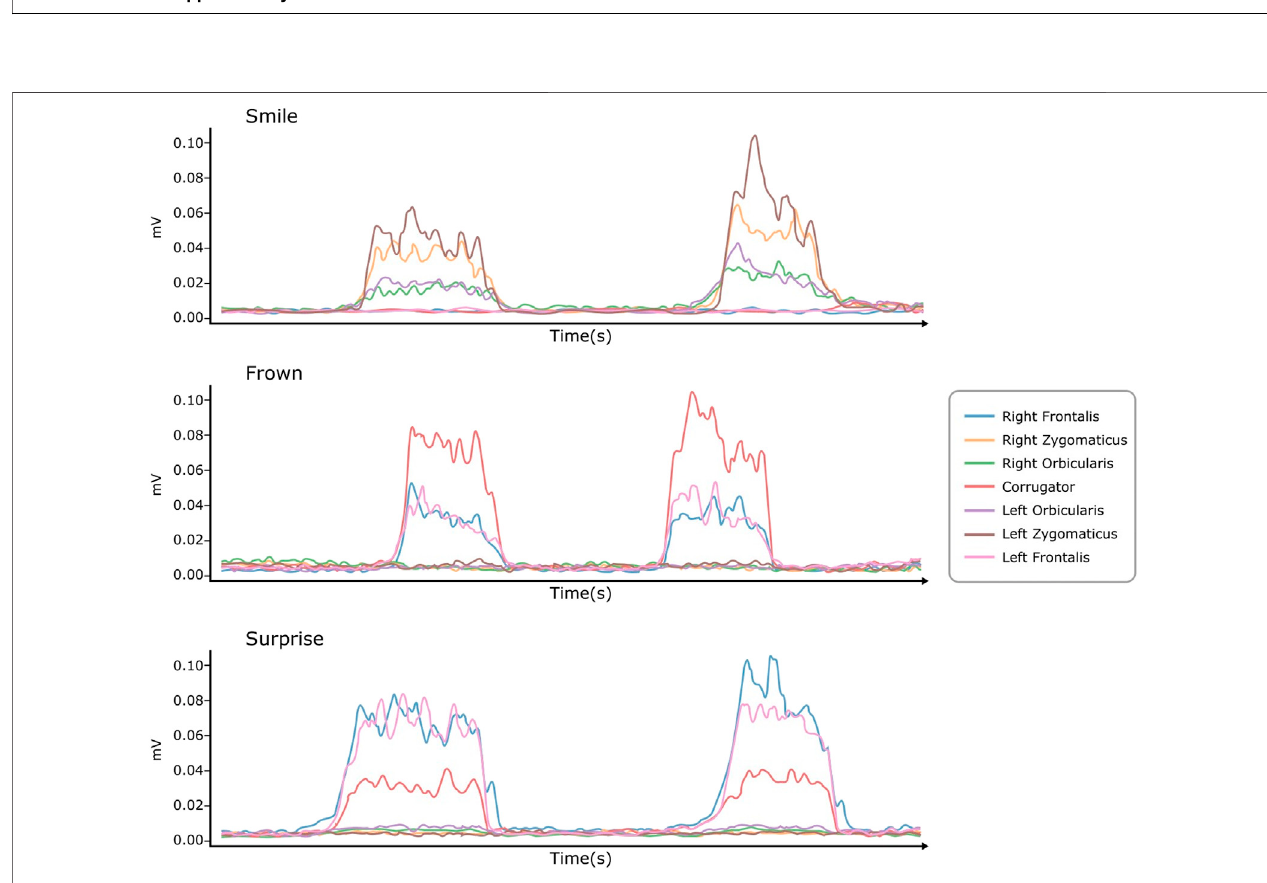
FIGURE 13 | EMG signal depicting facial muscle activation of individual muscles when performing smile, frown and surprise expressions. Signals shown in this fi gure can be downloaded from Supplementary Datasheets S1 – S3 .